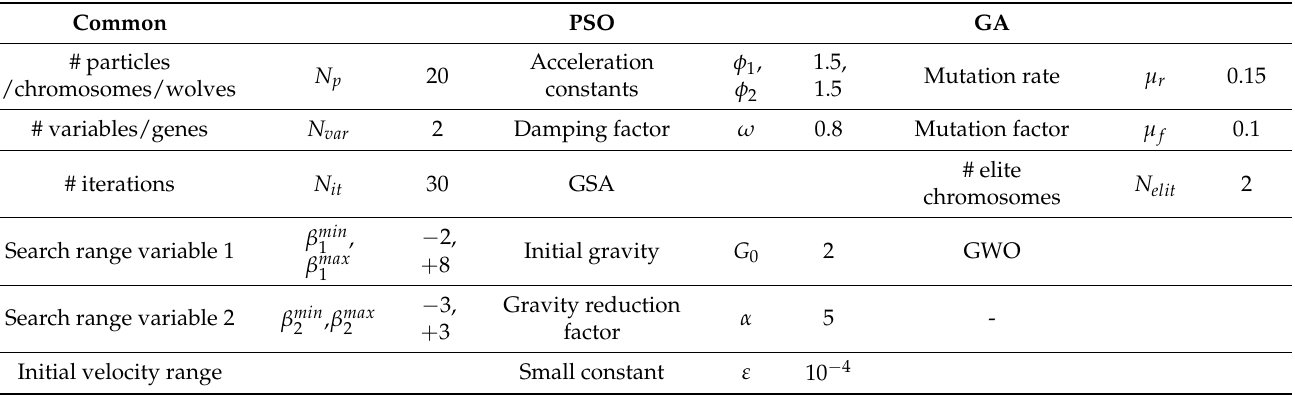
Table A4. Optimization algorithm parameters. No algorithm specific parameters were required for